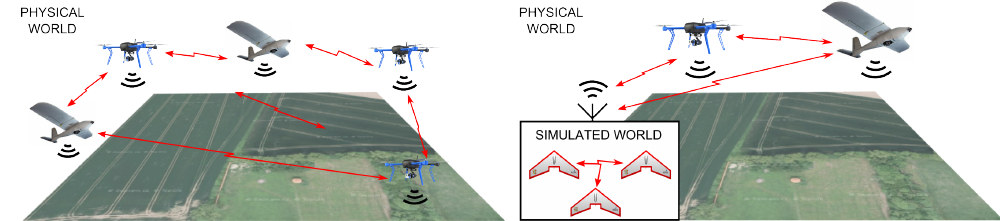
Figure 1. Visualization of the problem of maintaining high fidelity in communication system models in mixed-reality (MR)